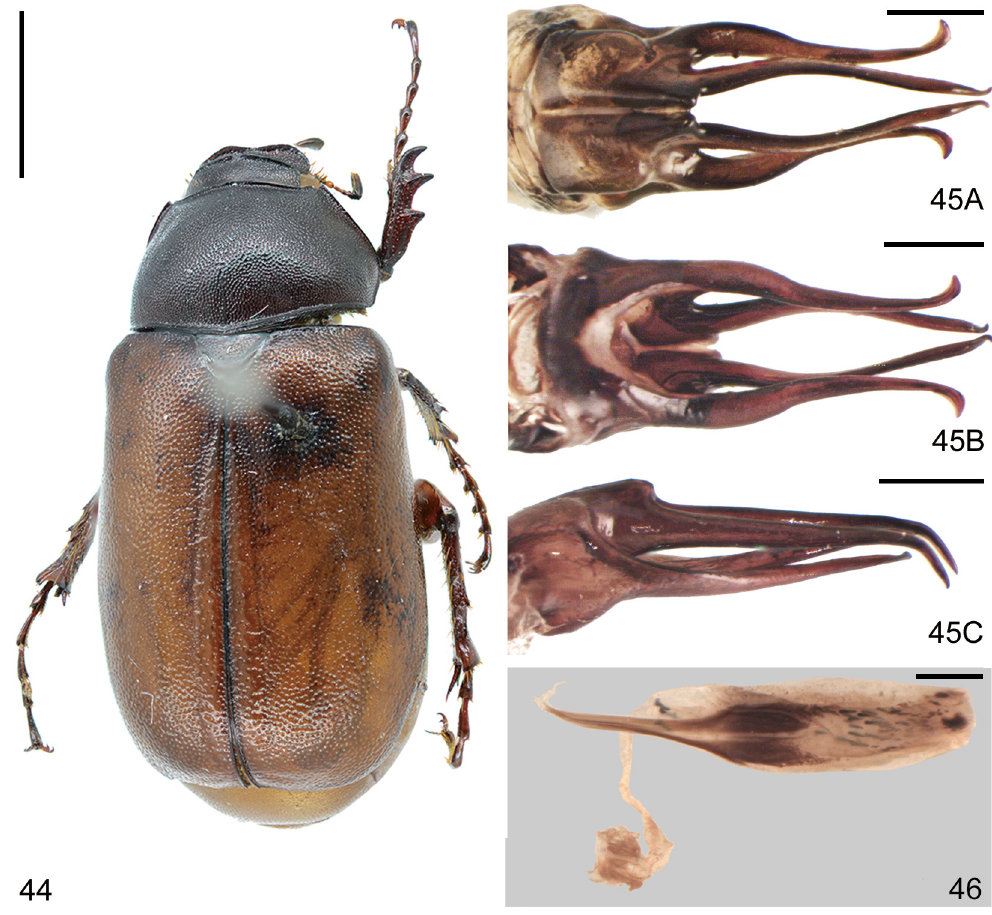
Figs 44–46. Miridiba imitatrix (Brenske, 1899), lectotype (MFNB). 44 . Habitus in dorsal view. 45 . Parameres in dorsal (A), ventral (B) and lateral (C) views. 46 . Endophallus and temones in dorsal view. Scale bars: 44 = 5.0 mm; 45–46 = 1.0